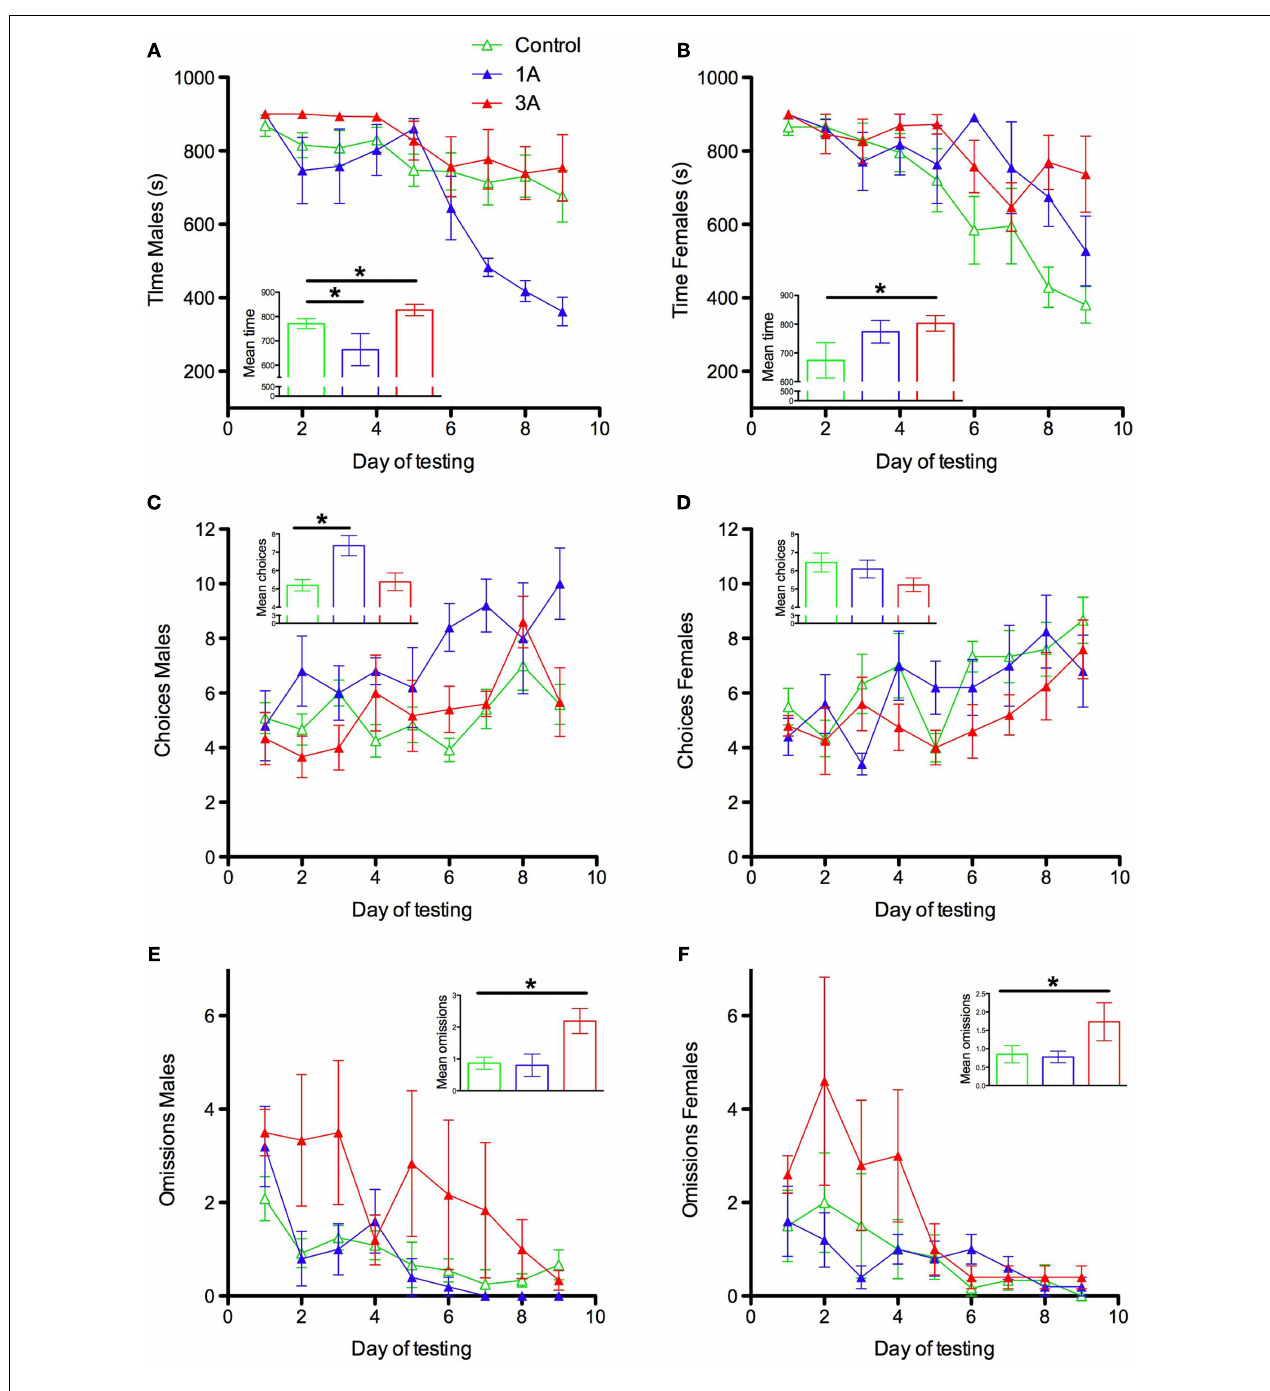
rewards up to a maximum of 900s; Choices = the number of arm choices made during a trial before the first error occurred; Omissions = the number of unvisited arms at the end of a trial. * p ≤